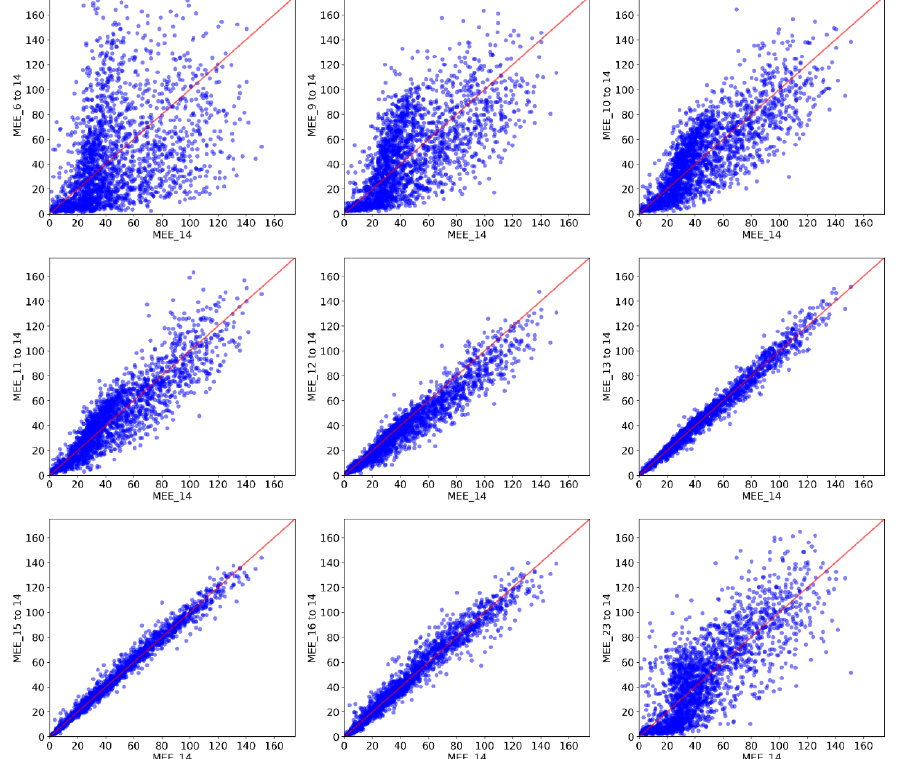
Figure 4. The relationship of ozone mixing ratio at 14:00 BJT measured by MEE and ozone mixing ratio at other time (06:00 BJT, 09:00 BJT, 10:00 BJT, 11:00 BJT, 12:00 BJT, 13:00 BJT, 15:00 BJT, 16:00 BJT, 23:00 BJT) with adjustment to 14:00 BJT. The red line is the 1:1 line. After IAGOS data adjustment, the monthly average surface ozone mixing ratio at 14:00 BJT in Beijing measured by IAGOS, ozonesonde and MEE is shown in Figure 5a.